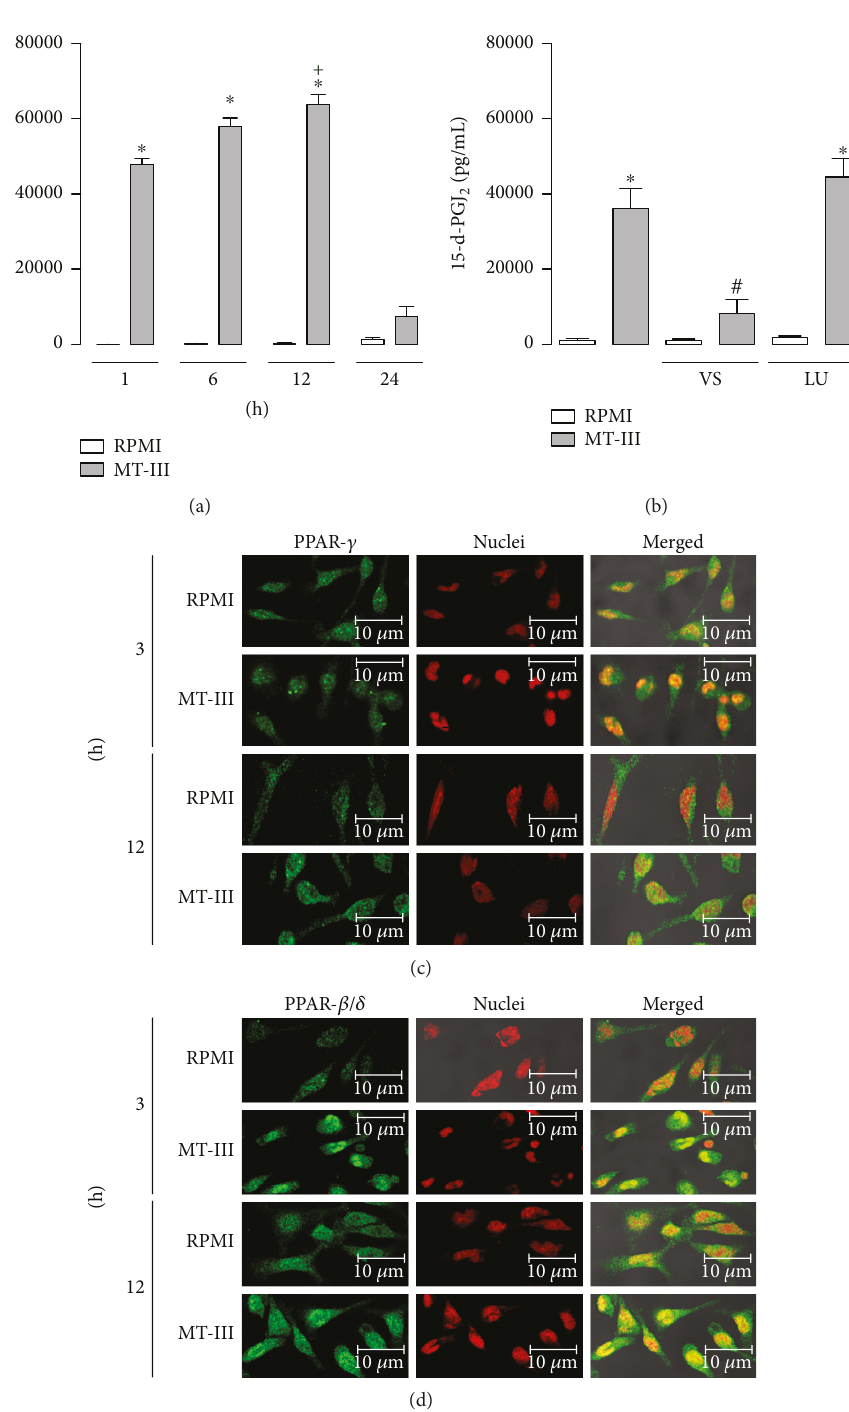
Figure 3: MT-III induces 15-d-PGJ production dependent on COX-1 and COX-2. PPAR- γ and PPAR- β / δ are activated by MT-III. 2 (a) Quanti fi cation of 15-d-PGJ in macrophage culture supernatants by speci fi c EIA. ∗ p < 0 05 compared with control group; + p < 0 05 2 as compared with MT-III-stimulated cells for 1 h. (b) Macrophages were pretreated with COX-1 (valeryl salicylate (VS)), 10 μ M, or COX-2 (lumiracoxib (LU)) 10 μ M inhibitors for 1h before stimulation with MT-III (0.4 μ M) for 6h, and 15-d-PGJ quanti fi ed by ELISA. ∗ p < 0 05 compared with control group; # p < 0 05 compared with MT-III- stimulated cells. (c, d) Macrophages incubated with RPMI (control) or MT-III (0.4 μ M) for 3 or 12h were labelled with anti-PPAR- γ (b) or PPAR- β / δ (d) conjugated to Alexa 488 (green). Nuclei were stained with iodide propidium. The pictures are representative of three independent